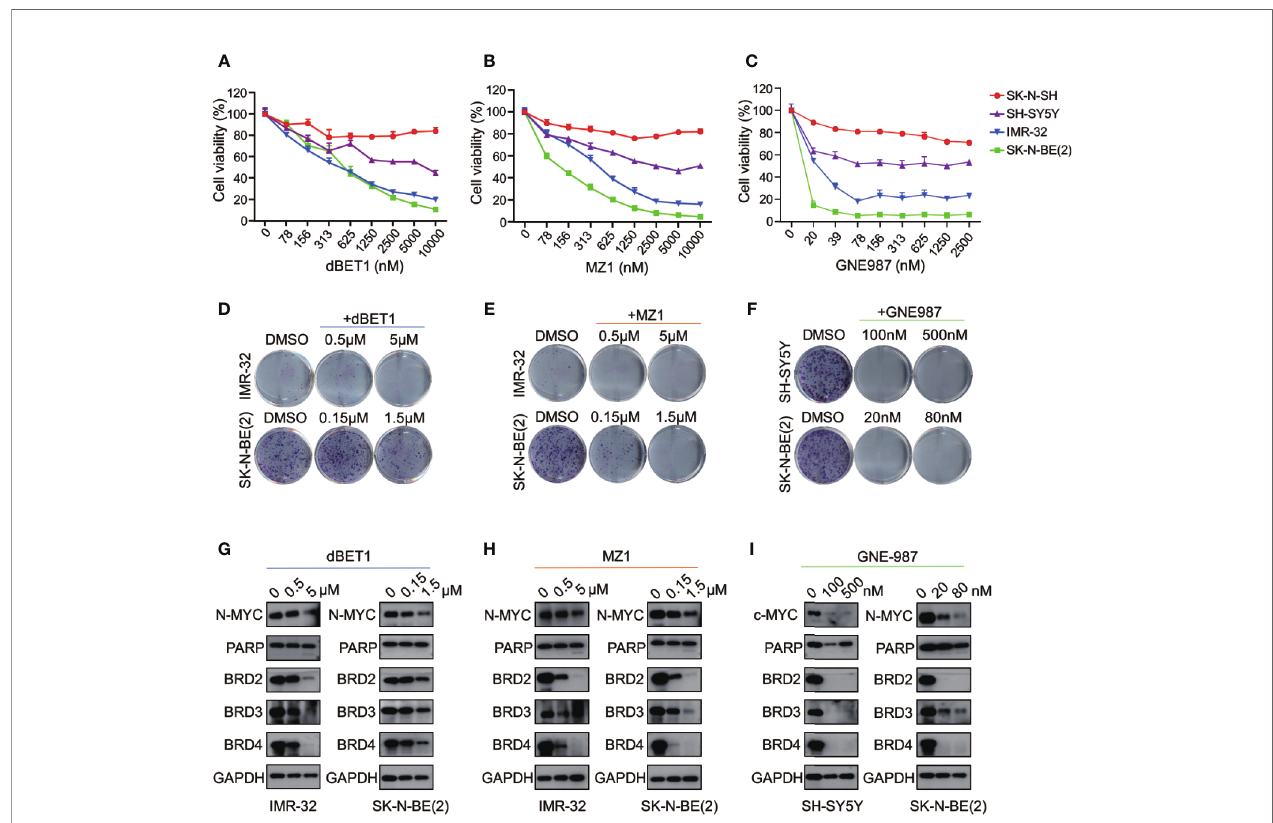
FIGURE 9 | BRD4 PROTAC inhibitors suppressed proliferation in NB cells. CCK8 assay showed that cell proliferation rates were reduced in NB cells treated with serial concentration of dBET1 (A) , MZ1 (B) , and GNE987 (C) for 72 h. Clone formation ability was reduced in NB cells after 7 – 14 days of dBET1 (D) , MZ1 (E) , and GNE987 (F) treatment. Western blot showed BRD4 PROTAC inhibitors dBET1 (G) , MZ1 (H) , and GNE-987 (I) depleted BRD2, BRD3, and BRD4 protein, repressed MYCN or c-Myc expression and induced PARP cleavage in NB